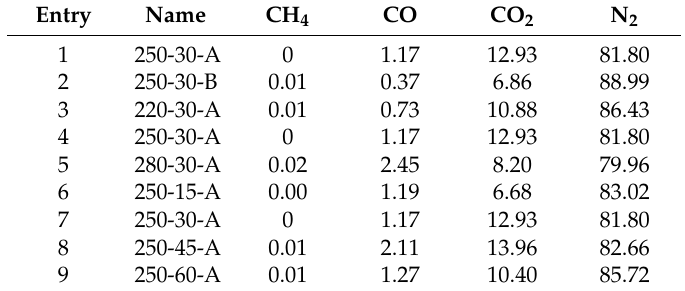
Table 7. Concentration of gaseous products (relative to N 2 upon GC analysis) under various